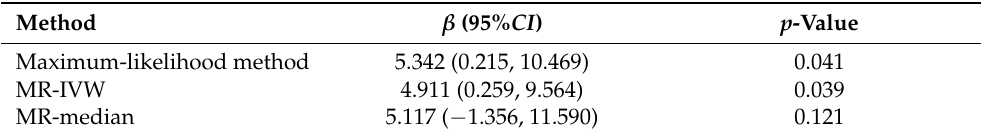
Table 4. Mendelian randomization causal-effect estimates for SOCS3 methylation level with abdomi- nal